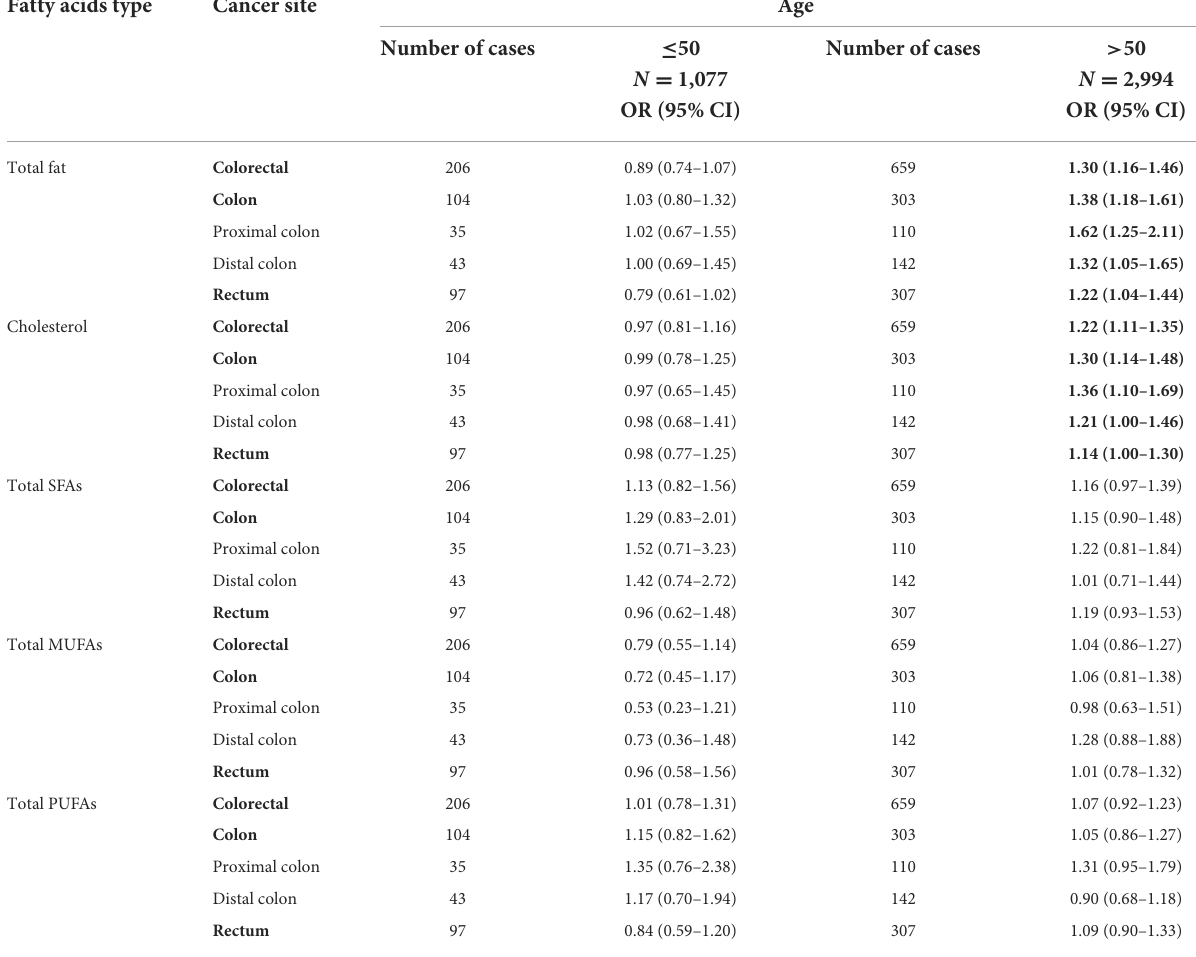
TABLE 4 Odds ratios and 95% confidence intervals of colorectal cancer and specific fatty acids intakes stratified by